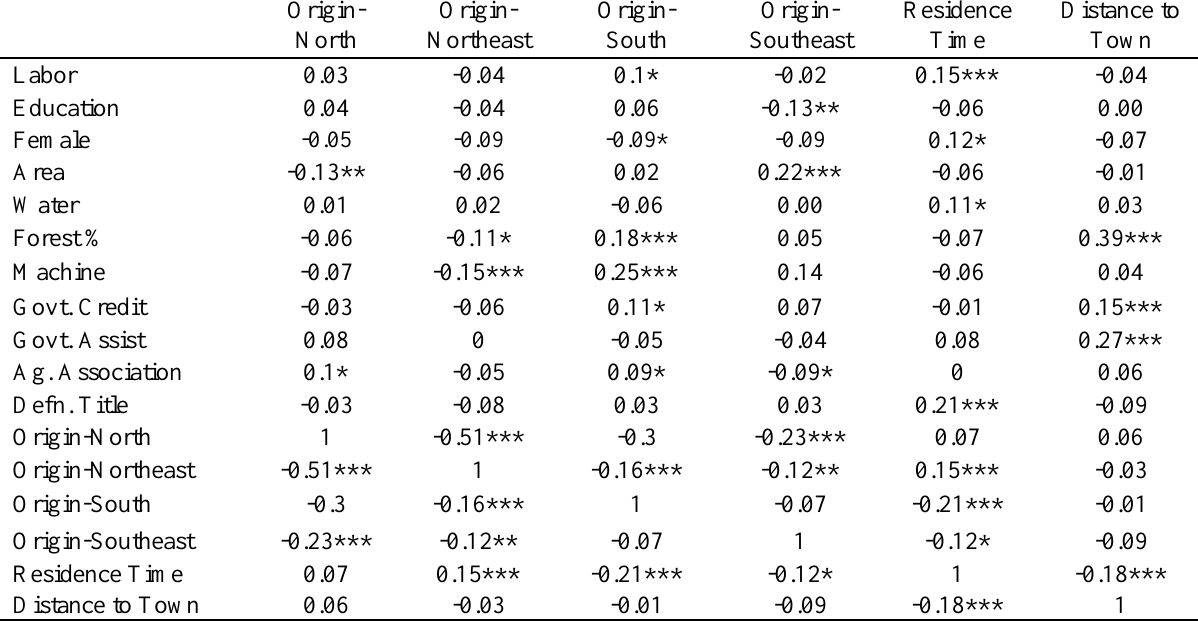
Table A3.1: Correlation table for all explanatory variables analyzed in this study,